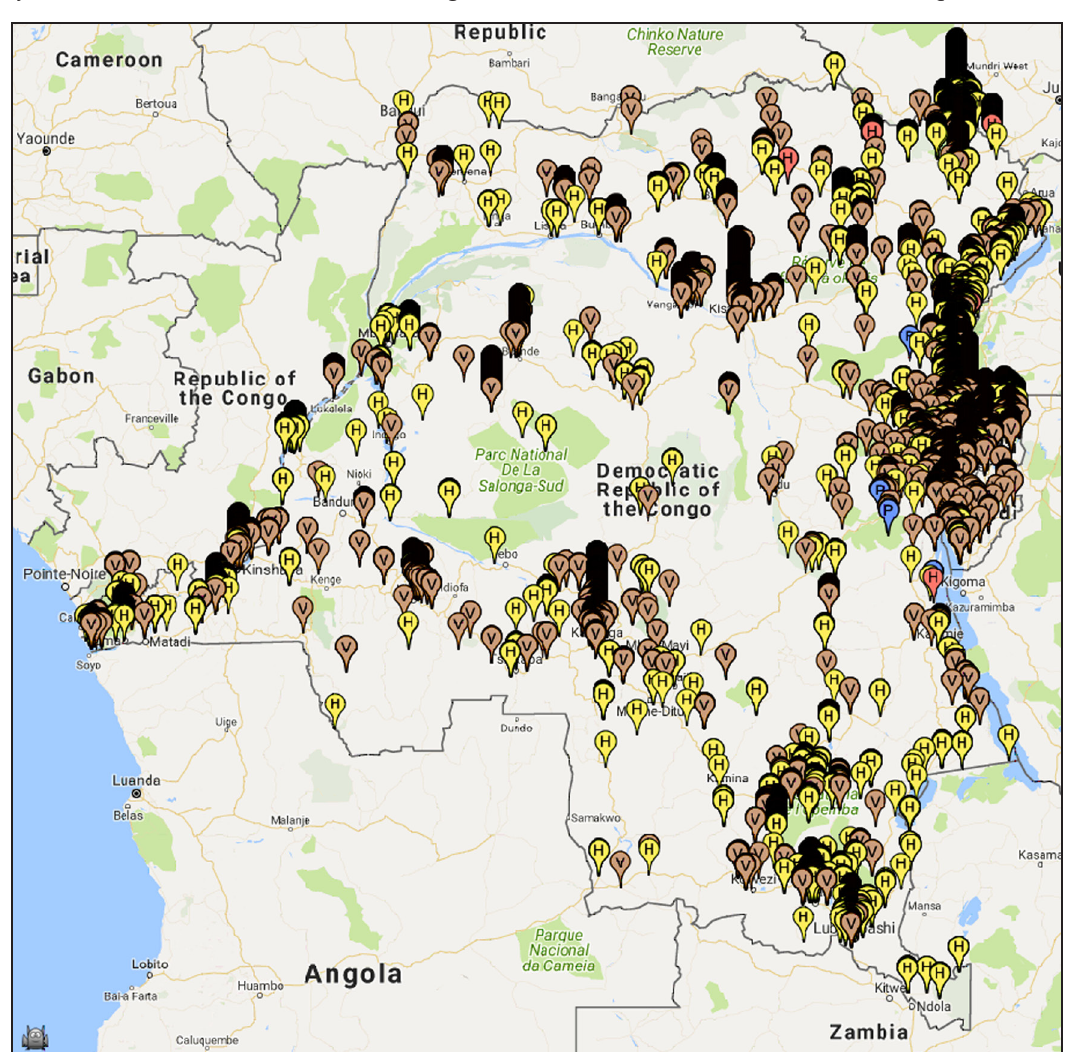
Fig. 1. Capture localities for all bats. The symbols represent: yellow (H): records included in Hayman et al . (1966), and brown (V): newly added records. Other coloured pins represent type specimens: red (H): holotype, blue (P): paratype or paralectotype (for further details, see